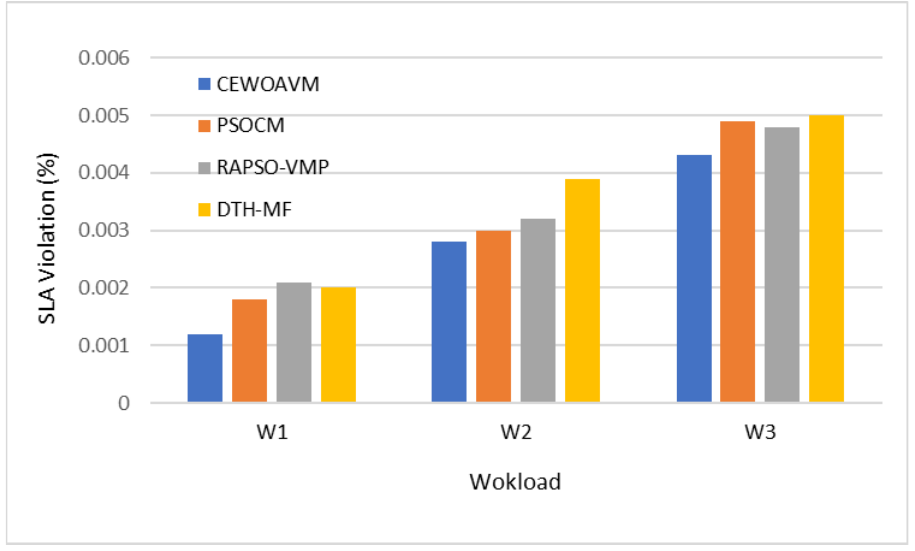
Figure 6. Comparison analysis of SLA violations.